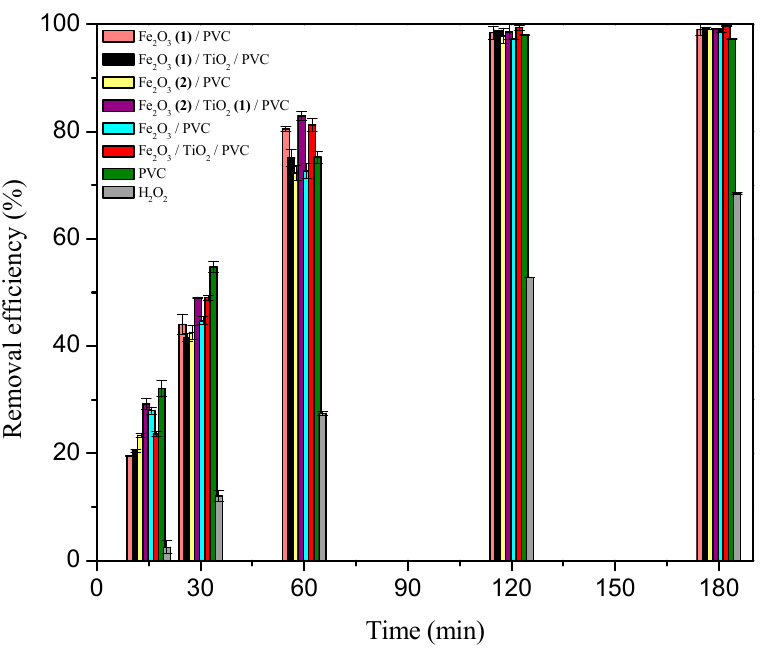
Figure 6. MB removal efficiency ( c 0 = 2.45 · 10 − 2 mM) in the presence of 29 tablets of Fe 2 O 3 /TiO 2 /PVC composites, 13.1 mM H 2 O 2 , at a stirring rate of 490 rpm under SSR.